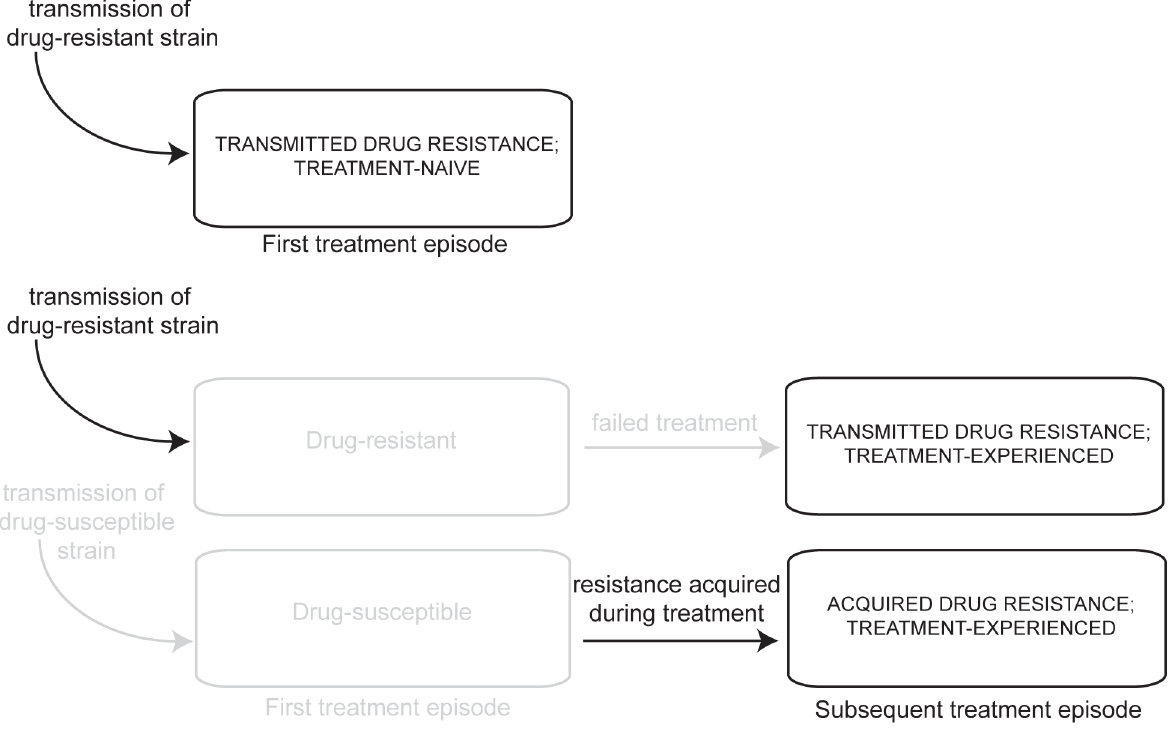
Figure 1. Mechanisms of TB drug resistance in treatment-naı¨ve and experienced patients. The first pathway describes patients who test positive for resistance to anti-TB drugs prior to their first treatment episode. These treatment- naı¨ve patients were initially infected with a drug- resistant strain. The second pathway describes patients who were infected by a drug resistant strain and failed their first course of treatment. After their first course of treatment, they tested positive for resistance to anti-TB drugs. The final pathway describes patients who were infected by a drug susceptible strain and failed their first treatment episode because they acquired resistance via spontaneous mutation.